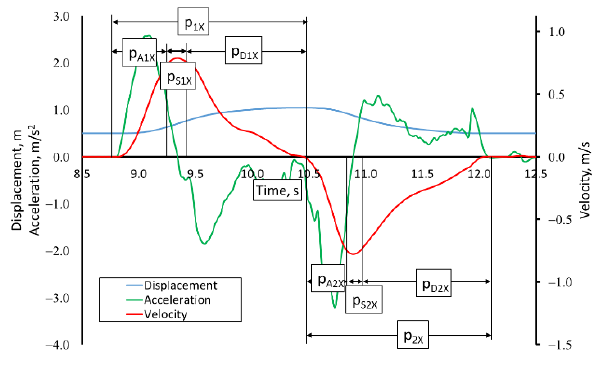
Figure 7. An example of the course of changes in displacement, velocity, and acceleration for the hand longitudinal movement (displacement: 430 mm), where p is the phase of the movement.